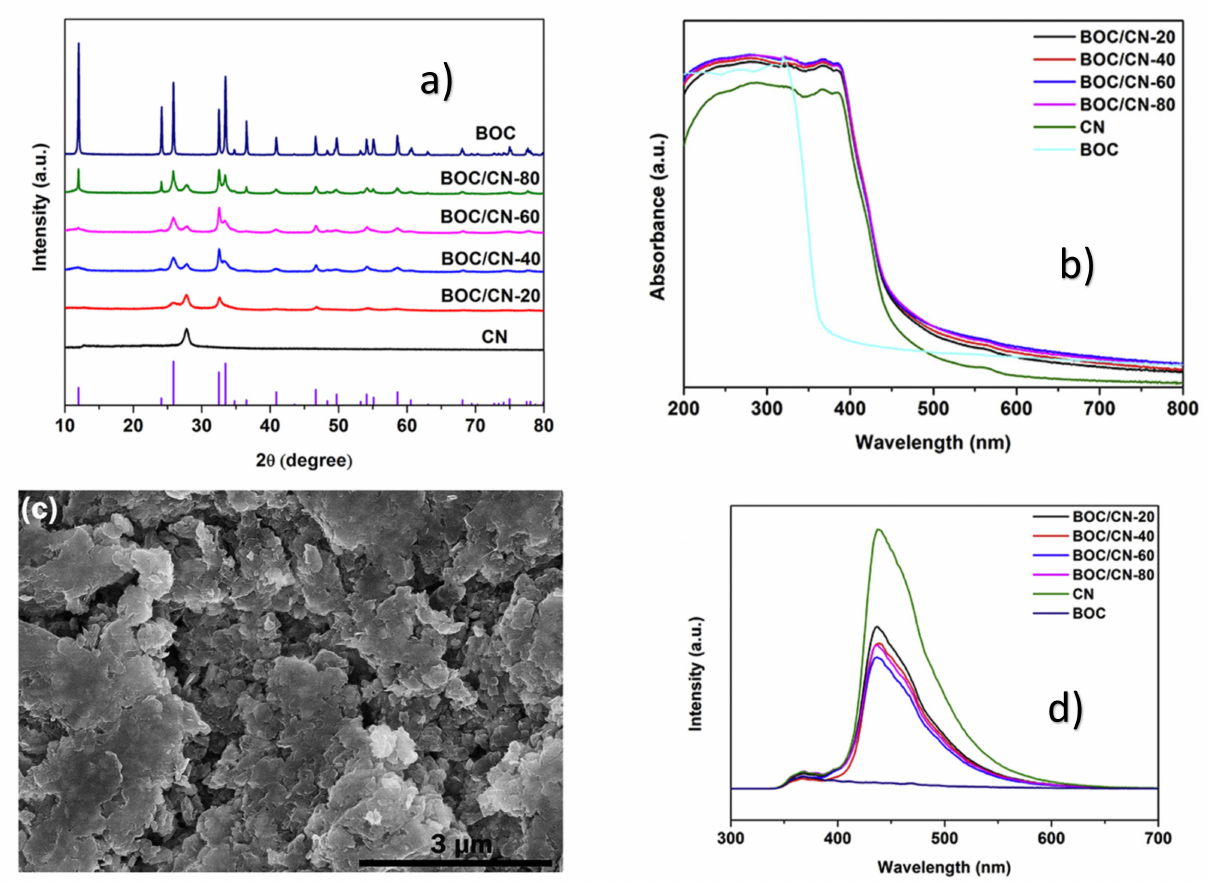
Figure 8. ( a ) XRD data, ( b ) UV-Vis DRS spectrum, ( c ) SEM, ( d ) photoluminescence spectra of all the samples. Reproduced with permission from Zhang X et al, Applied Surface Science; published by Elsevier BV,